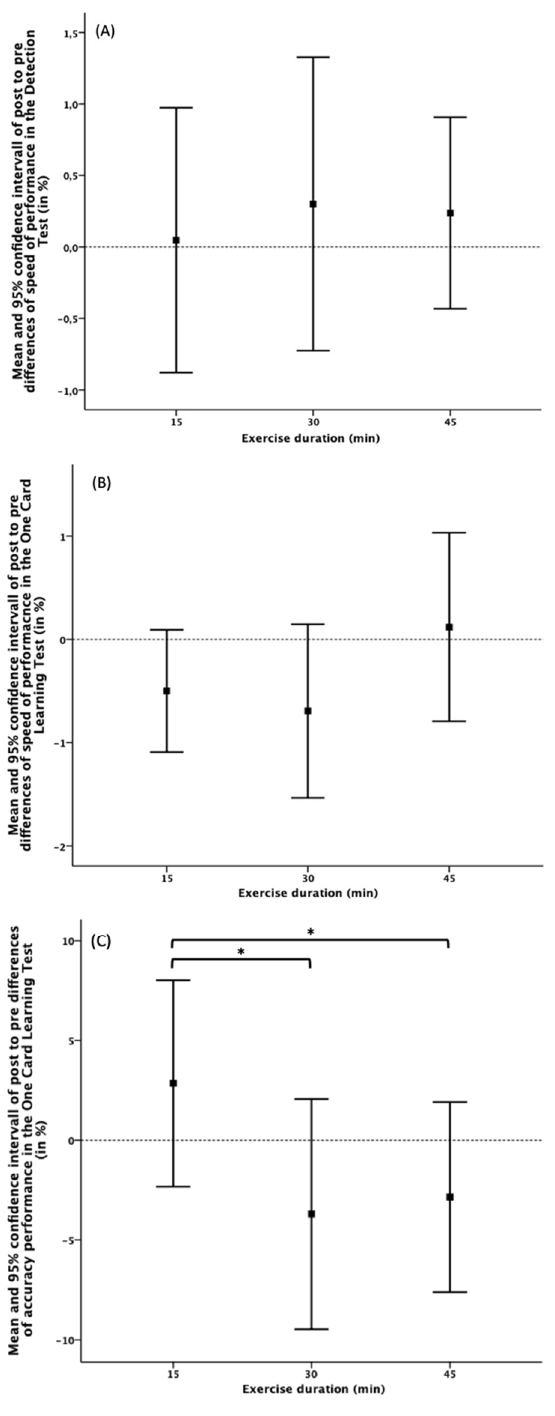
Figure 2. Means and 95% confidence intervals of changes in reaction time after aerobic exercise in the Detection Test (DET) ( A ) and One Card Learning Test (OCL) ( B ), as well as changes in OCL accuracy performance ( C ). * indicates significant differences ( p ≤ 0.05).